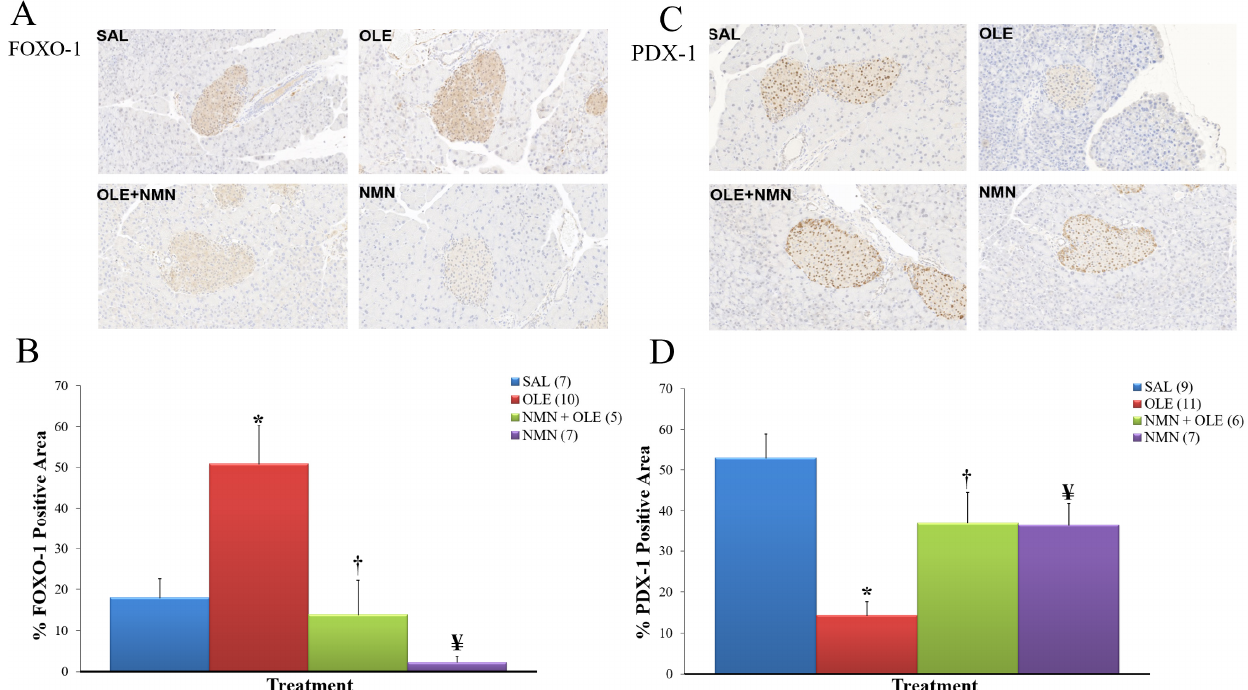
Figure 6. FOXO-1 and PDX-1 protein expression in pancreatic islets. Representative images of immunohistochemical staining of FOXO-1 ( A ) and PDX-1 (C) in pancreatic islets of mice treated with SAL, OLE, NMN + OLE, or NMN alone. ( B , D ) Quantification of FOXO-1 and PDX-1 positive area over total area of pancreatic islets. Data are means ± SE. Number in parentheses represents number of animals. * p < 0.05, SAL vs. OLE; † p < 0.05, OLE vs. NMN + OLE; ¥ p < 0.05, OLE vs. NMN.